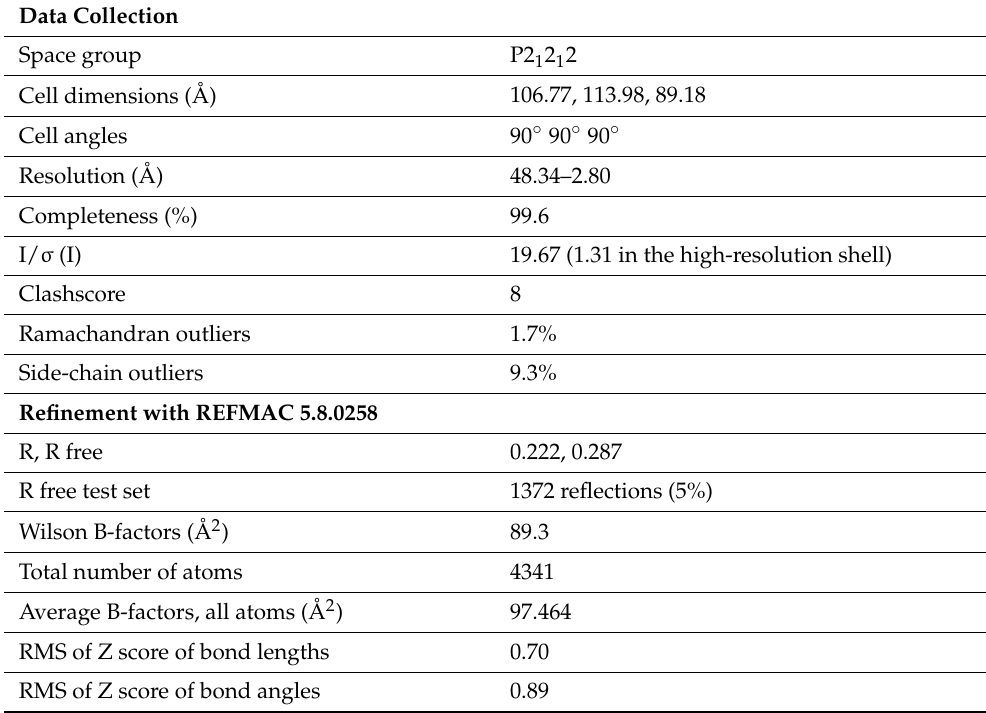
Table 1. Data collection and structure refinement statistics for KirBac